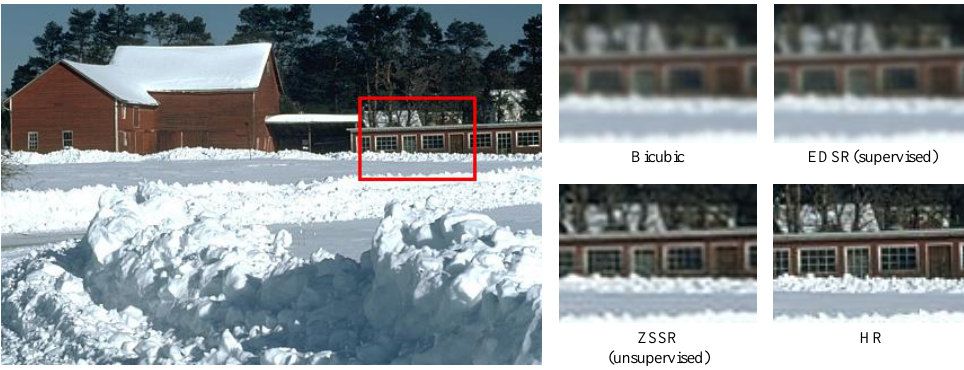
Figure 2. The comparison of supervised and unsupervised SR learning under "non-ideal" downscaling kernals condition. The unsupervised DL-SR method (ZSSR) firstly estimate the PSF, and learning internal information by a small CNN. The supervised method is one of the best ones named EDSR which is trained by a lot of image pairs. The comparing result shows that the unsupervised method surpasses the supervised method in the repetitive details, which potentially indicates the validity of internal recurrence for SR